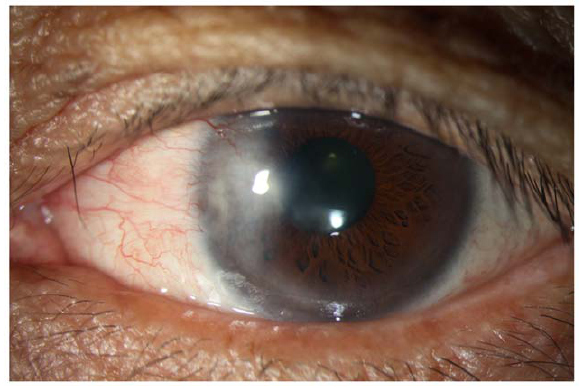
Figure 1. Ocular surface of a patient who underwent pterygium surgery three times before receiving Sr90 irradiation. A visual acuity of 18/20 was observed at the 10-year